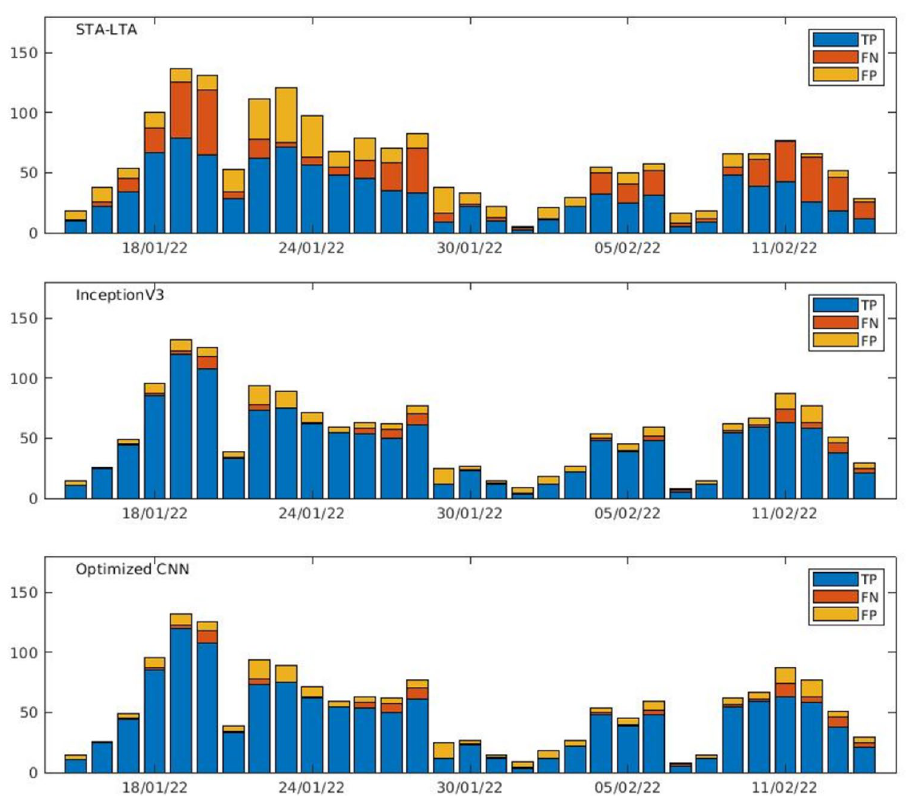
Figure 7. Distribution of daily numbers of DAS detected events using STA-LTA algorithm, the InceptionV3 and the optimized